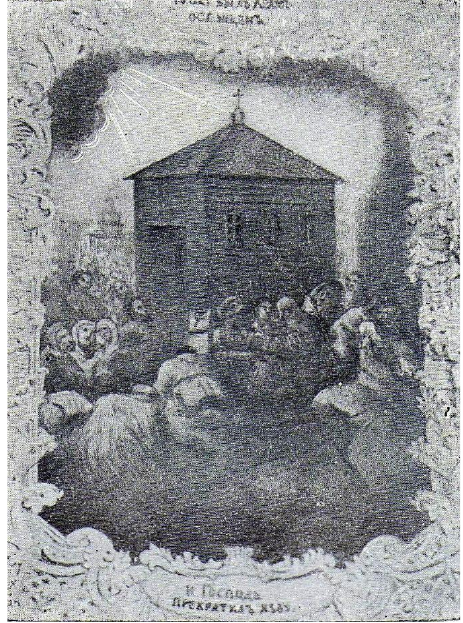
Figure 3. Construction of “Saviour-Vsegradsky” (Spaso-Vsegradsky) one-day church in Vologda, October 1654. Print in the collection of Spaso-Vsegradsky Cathedral. (Anonymous 17th c.).